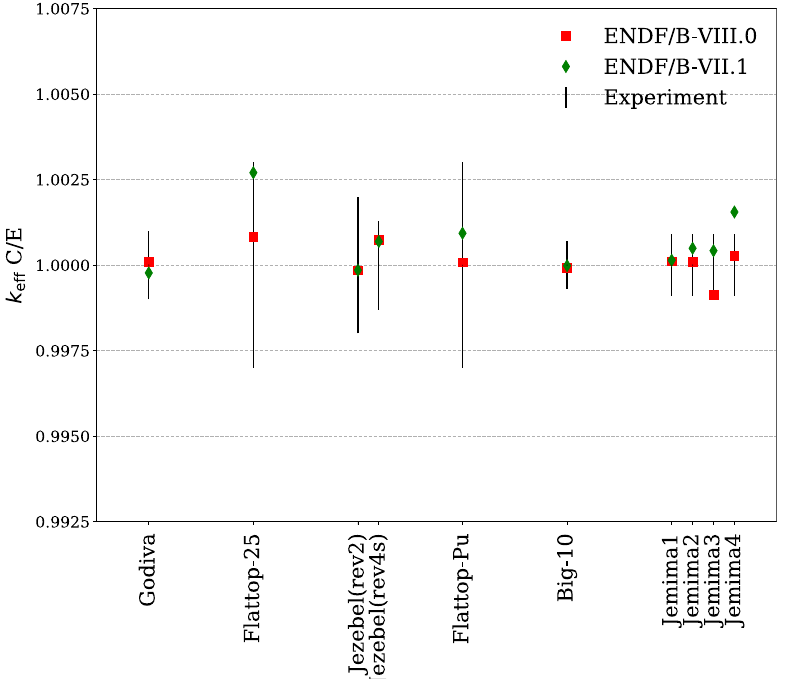
Fig. 3. Basic benchmarks used in the validation of the ENDF/B-VIII.0 library [3]. Overall the ENDF/B-VIII.0 library (in red) performs even better than the ENDF/B-VII.1 (in green) for this particular suite of integral benchmarks.